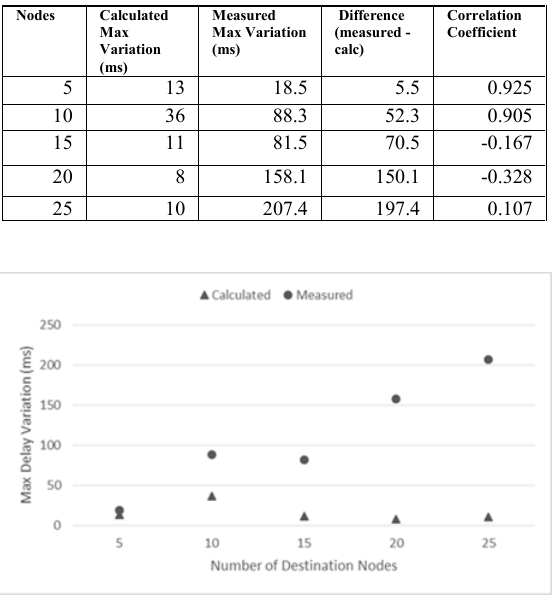
Fig. 11. Average Delay for Multicast Network with 30 Nodes and 15